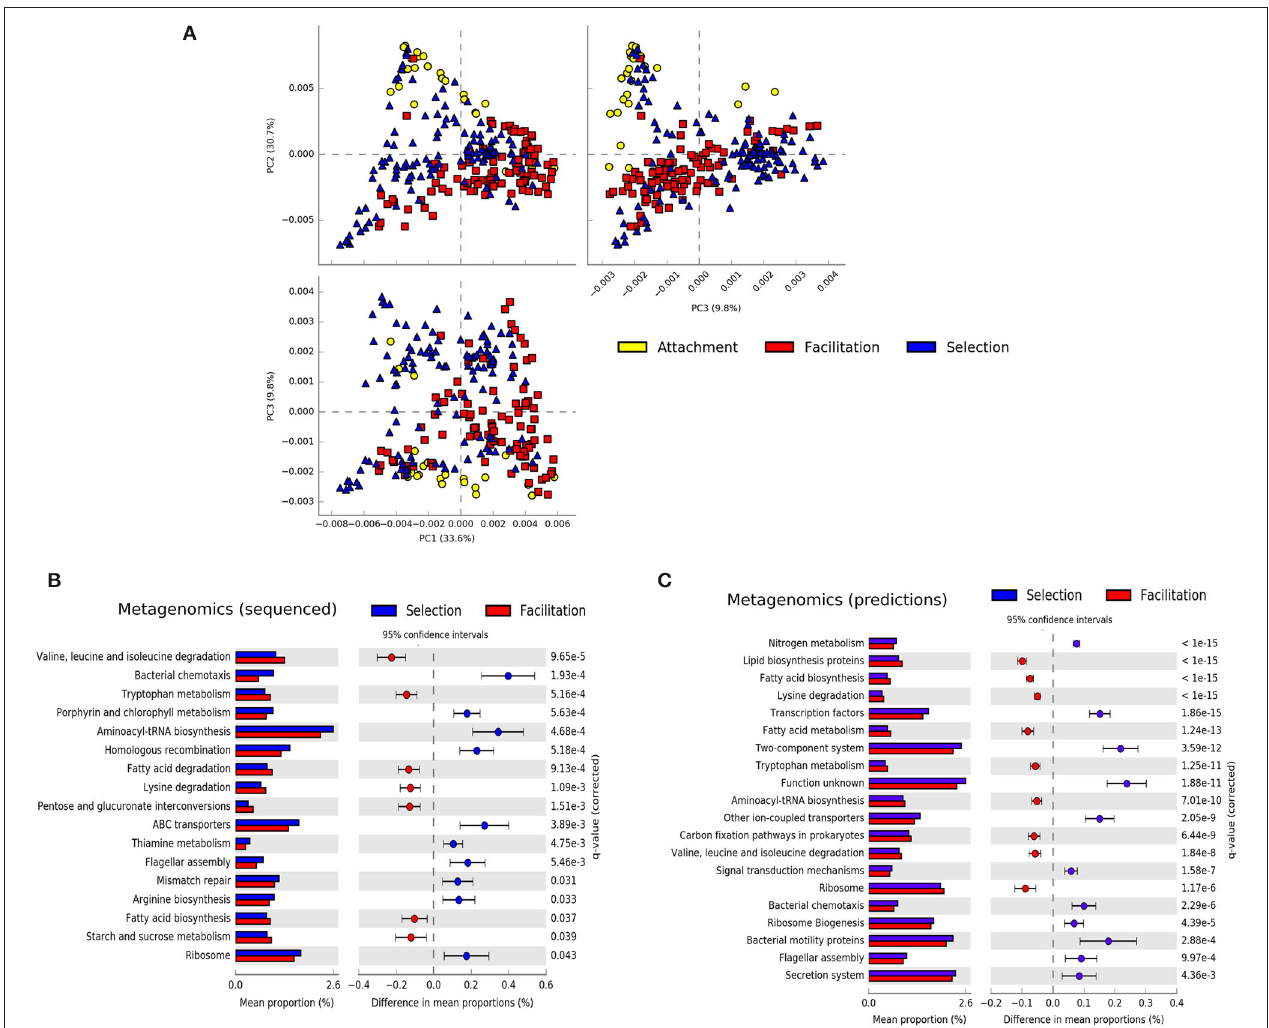
FIGURE 4 | Summary of metagenomic features. (A) Principal component analysis of the predicted metagenomic profiles colored by the phase in which they were sampled. Difference in the mean proportions of genes between communities at the selection and facilitation phases in metagenomic experiments (B) and in PICRUSt predictions (C) . Each row in the diagram represents genes classified in the KEGG pathway indicated. The first column represents the mean proportions of the genes in the pathway for each phase, and the second column represents the difference between those proportions. Adjusted Benjamini-Hochberg p -values and 95% CI intervals are indicated. Pathways with effect sizes lower than 0.1 (B) and 0.05 (C) were filtered to show a similar number of